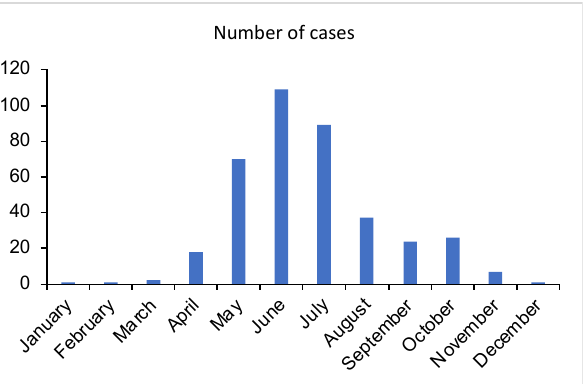
Figure 1. Histogram of cases by admission date. Of the 4698 total, 385 patients were selected based on the case de fi nition relating to potential TBDs.